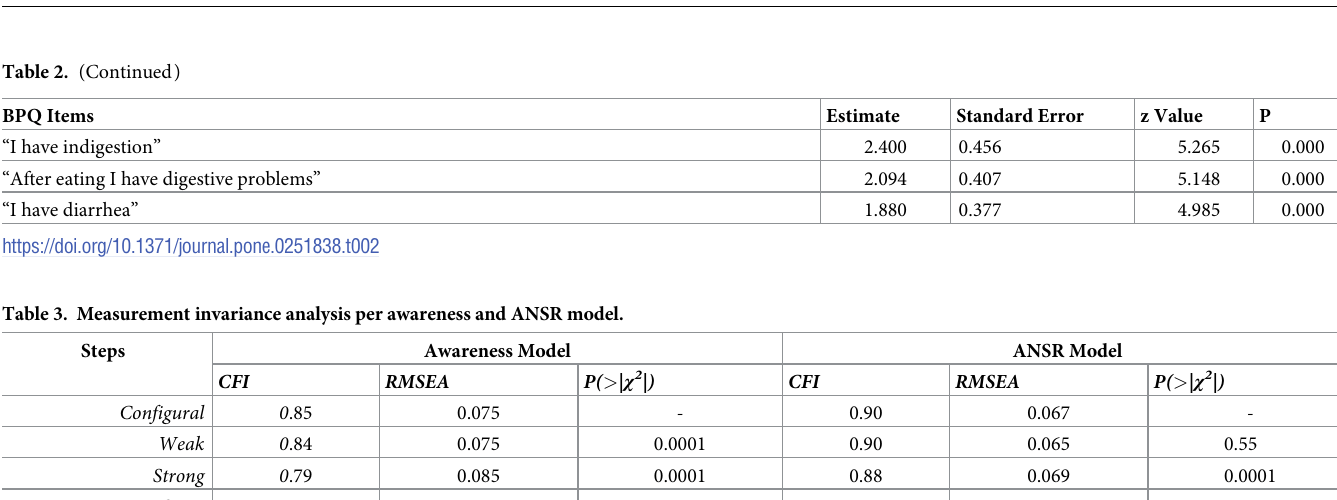
Table shows the results of the Measurement Invariance Analysis for Awareness and ANSR models. The rows are the steps of testing invariance in order to increase constrains (from Configural to Strict). The columns show the values of Comparative Fit Index (CFI) , Root Mean Squared Error of Approximation (RMSEA) and of P- value related to Chi square tests (P( > | χ 2|)) .